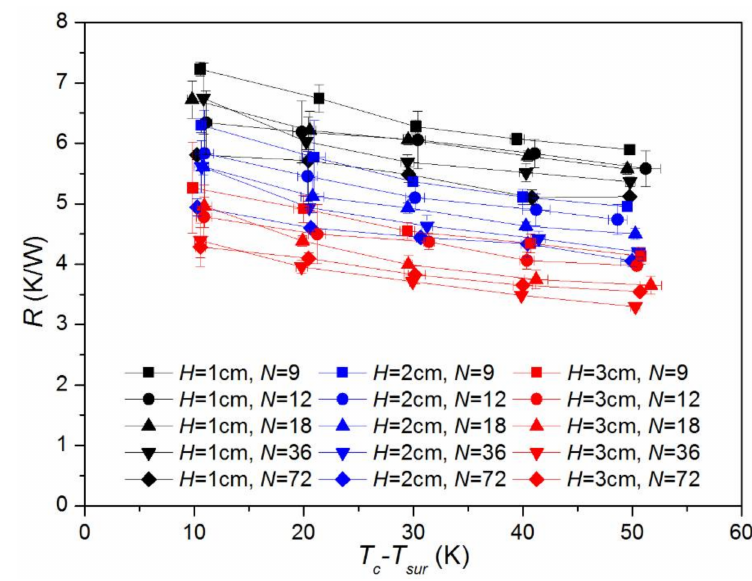
Figure 6. Thermal resistances for various temperature